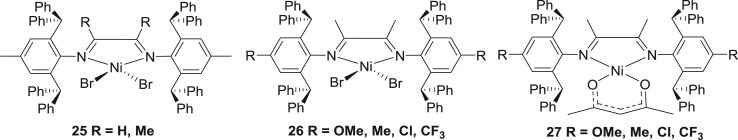
2,6-Dibenzhydryl-substituted symmetrical α-diiminobutene-nickel pre-catalyst 25–27.